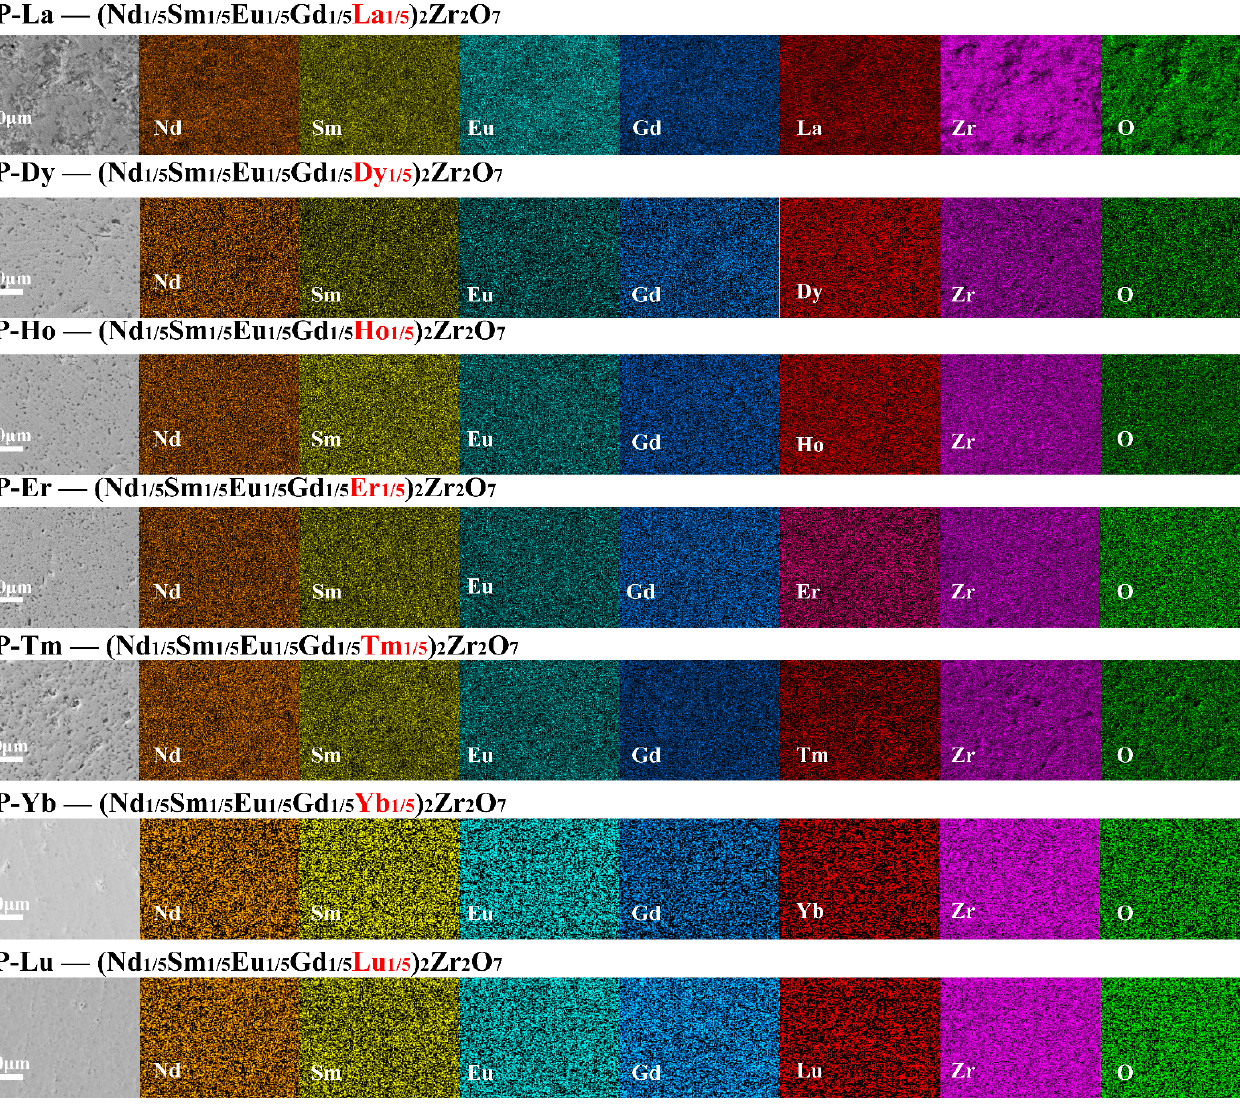
Figure 2. Cross-section SEM images and the corresponding EDS mapping of the seven com- pounds.